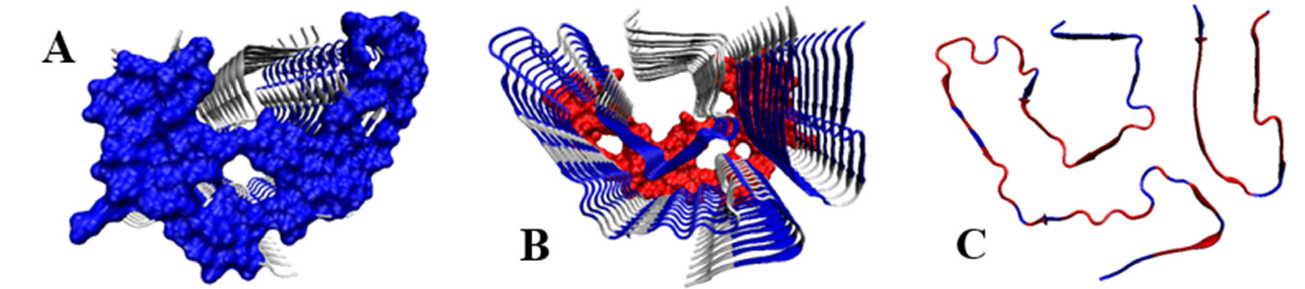
Figure 10. Presentation of a 3D transthyretin structure. ( A )—sections (navy blue) that meet the model’s conditions are highlighted, sections of proteins—amino acids with a conformation treated as outstanding; ( B )—red sections are sections that meet the conditions of the assumed model, sections of proteins—amino acids with a conformation treated as outstanding. Navy blue segments in the remaining chains—conformations meet the conditions of the model; ( C )—single chain: navy blue sections—sections with linear propagation, red sections—turns performed by a single (one amino acid in the sequence) L α or R α helical conformation (or a detailed overview in [29]).